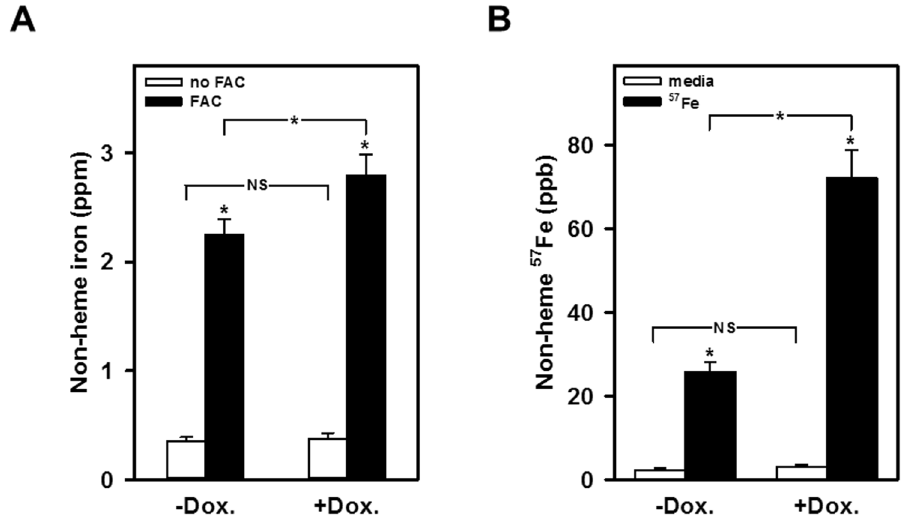
Figure 5. Iron accumulation is increased in mitochondria from rDMT1-overexpressing HEK293 cells, as measured by ICPOES and ICPMS. ( A ) Non-heme iron accumulation. Mitochondria were exposed to medium lacking or containing 100 µ M FAC for 4 h. Accumulation of non-heme iron was determined by ICPOES as described in the Methods. ( B) 57 Fe incorporation. Mitochondria were exposed to medium lacking or containing 10 µ M 57 Fe-FAC for 4 h. Incorporation of non-heme iron was determined by ICPMS as described in the Methods. Data are means ± SD of 6 determinations in two independent experiments, respectively. * Denotes statistical significance of differences on the P < 0.01 level as calculated using one-way analysis of variance. NS, not